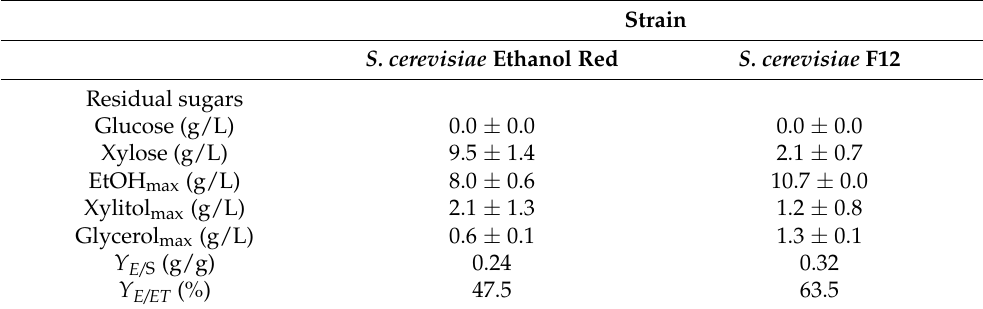
Figure 3. Time course for fermentation of synthetic medium using S. cerevisiae F12. Concentrations (g/L) of glucose, xylose, xylitol and glycerol and production (g/L) of ethanol are shown. Table 3. Summary of fermentation assays with S. cerevisiae Ethanol Red and S. cerevisiae F12 using synthetic